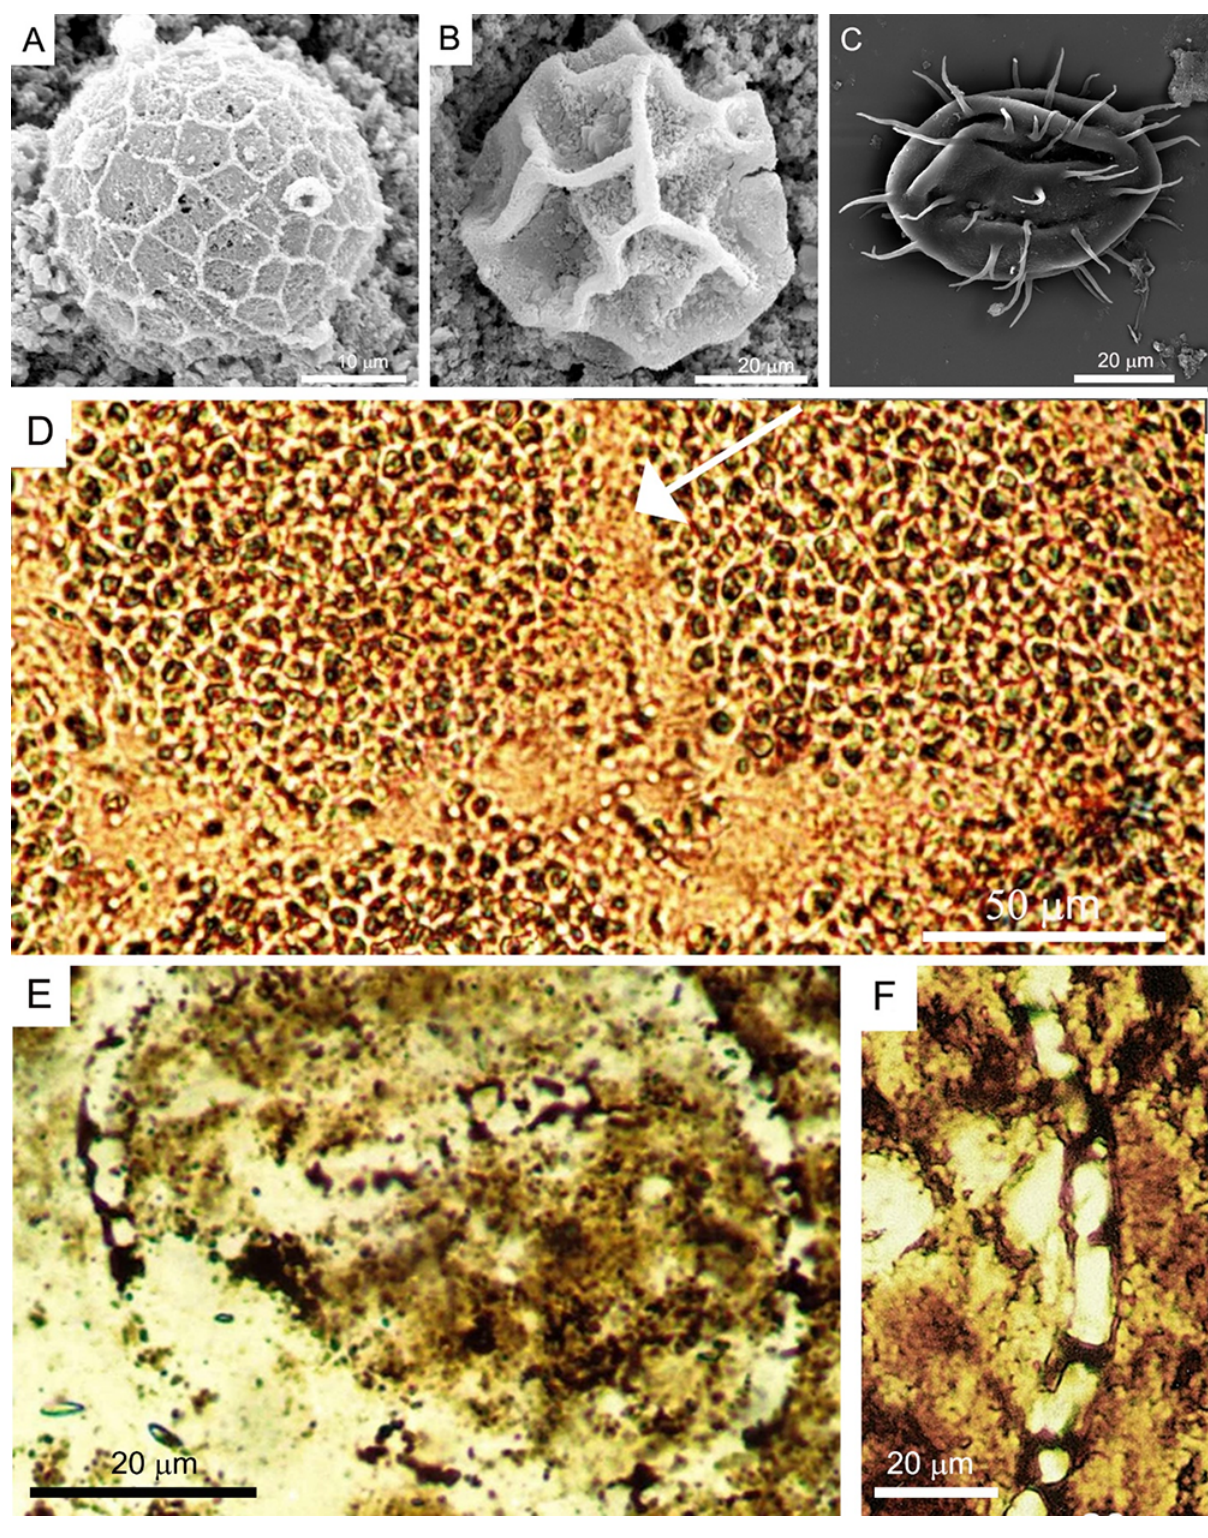
Figure 2 ( A,B ) Early Silurian (Llandoverian) herkomorph acritarchs. ( A ) Cymatiosphaera sp. and ( B ) Dictyotidium sp., Łupianka Hill near Żdanów scanning electron microscopy (SEM) images (by B. Kremer). ( C ) Gorgonisphaerdium ohioense , characteristic Late Devonian acritarch, Kowala quarry, Holy Cross Mountains. SEM image (by P. Filipiak). ( D ) Light micrographs of modern mat of benthic coccoid cyanobacteria (Sulejów Dam, central Poland). e mat is composed of globular colonies enclosed in thick envelopes (arrow) (photo J. Kaźmierczak). ( E ) ermally altered colony of Silurian coccoid cyanobacteria (Żdanów, the Bardo Mountains), originally composed of minute cells (photo J. Kaźmierczak). ( F ) e quasi-regular, segmented, blackish structures of thermal origin are strikingly similar to the purported Archaean Apex Chert microfossils (photo J. Kaźmierczak).